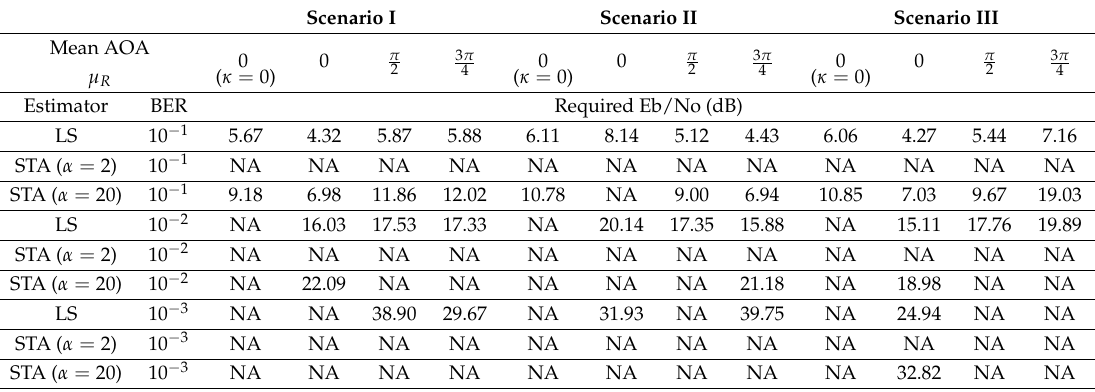
Figure 10. System performance over isotropic and non-isotropic scattering conditions with initial speeds of ν T = ν R = 100 km/h and acceleration components of a T = a R = 20 m/s 2 for Scenario I, by assuming a constant frame length of F = 32. Table 7. Required Eb/No levels to attain 10%, 1%, and 0.1% BER over Scenarios I, II, and III for isotropic and non-isotropic scattering conditions by considering initial speeds of ν T = ν R = 100 km/h and acceleration components of a T = a R = 20 m/s 2 , with a constant frame length of F = 32 (NA—not